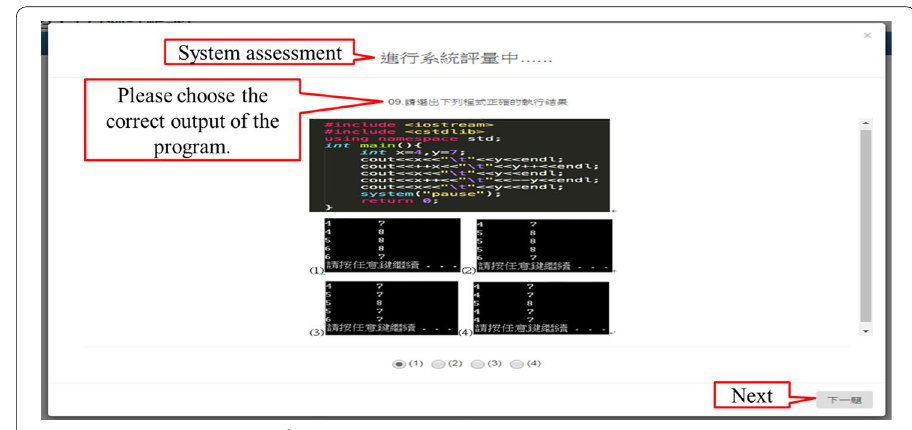
Fig. 5 System assessment interface